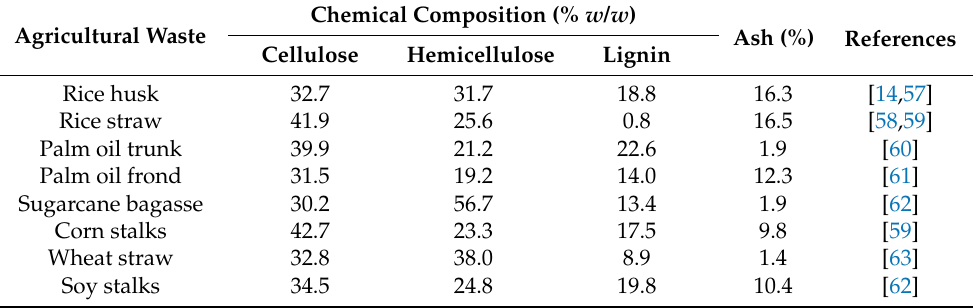
Table 3. Composition of agricultural